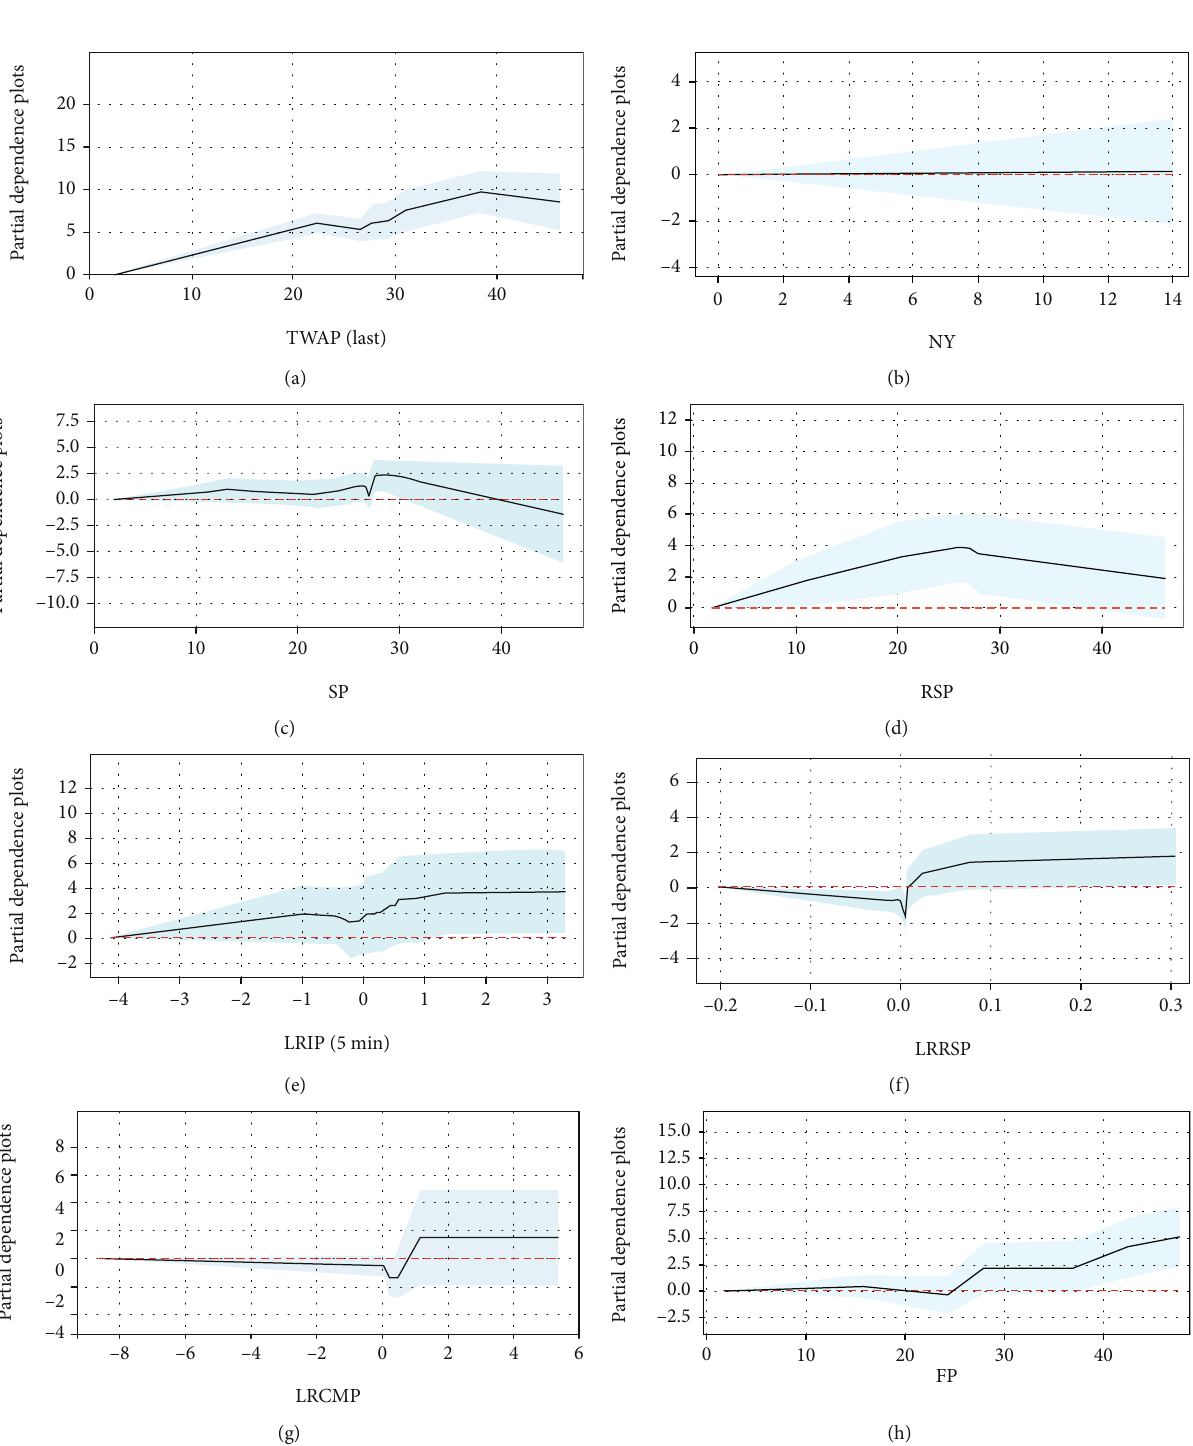
Figure 14: Partial dependence of the in fl uencing variables on TWAP